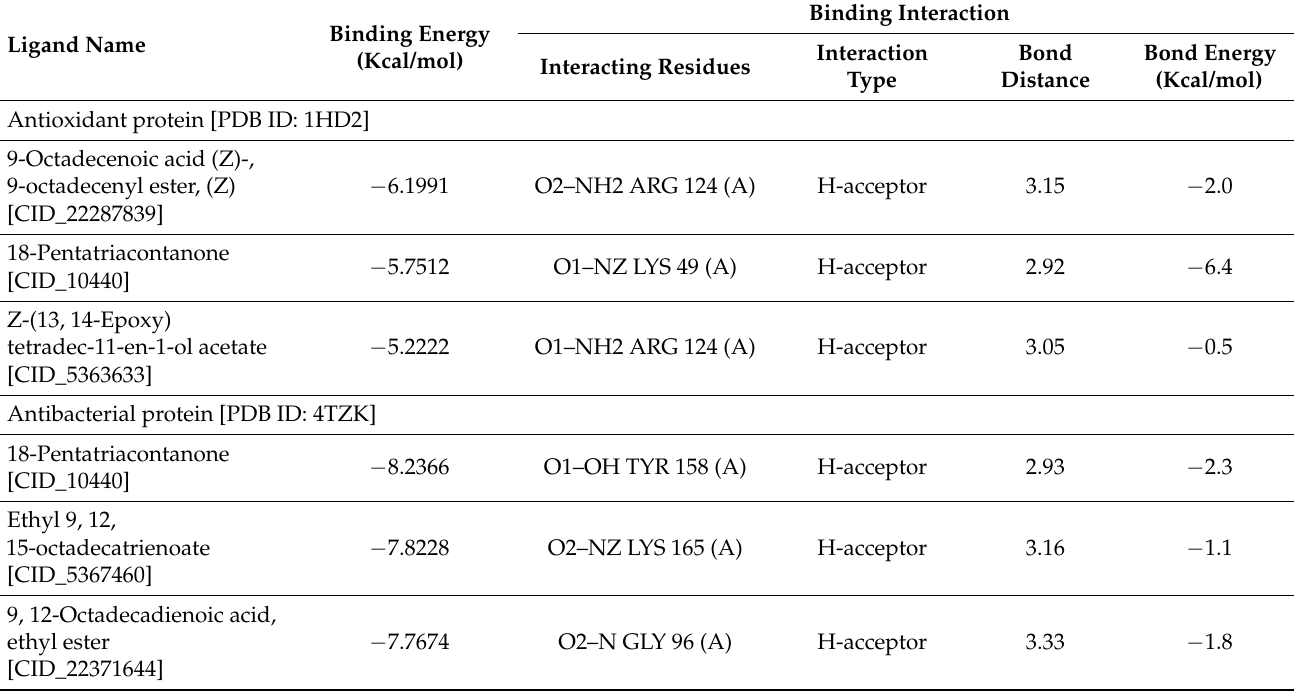
Table 5. Summary of interaction analysis of the two best virtual